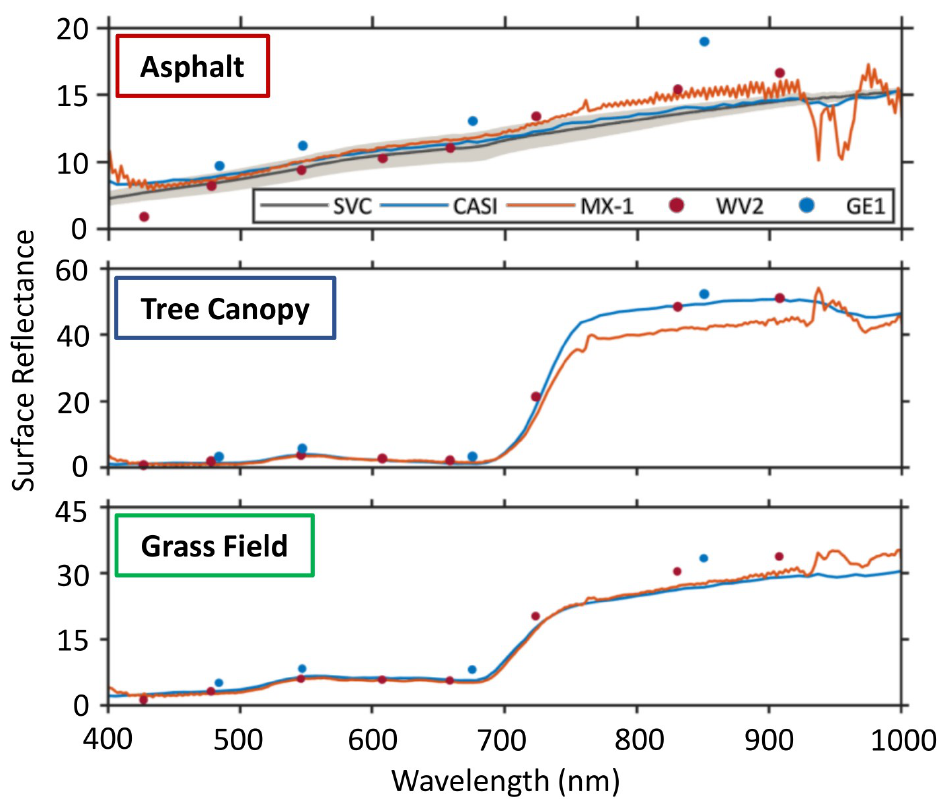
Figure 11. Surface reflectance measurements from all platforms showed agreement for asphalt ( top ), tree canopy ( middle ), and grass field ( bottom ) common target areas. Surface reflectance retrievals from UAV and airborne platforms agreed to within the variability of the ground truth measurements for the asphalt AOI, with the exception of atmospheric absorption features and the low signal region below 450 nm. Satellite retrievals showed magnitude bias but agreed in spectral shape. Artifacts due to water vapor changes during the experiment are evident in the MX-1 data for each AOI. While all assets viewed the area virtually simultaneously, airborne (CASI) and UAV (MX-1) sensors viewed the target area with a nadir geometry and satellite sensors observed from 31.7° (WorldView-2) and 25.9° (GeoEye-1) off-nadir. Variance and uncertainty estimates are not applied to imagery data for clarity of